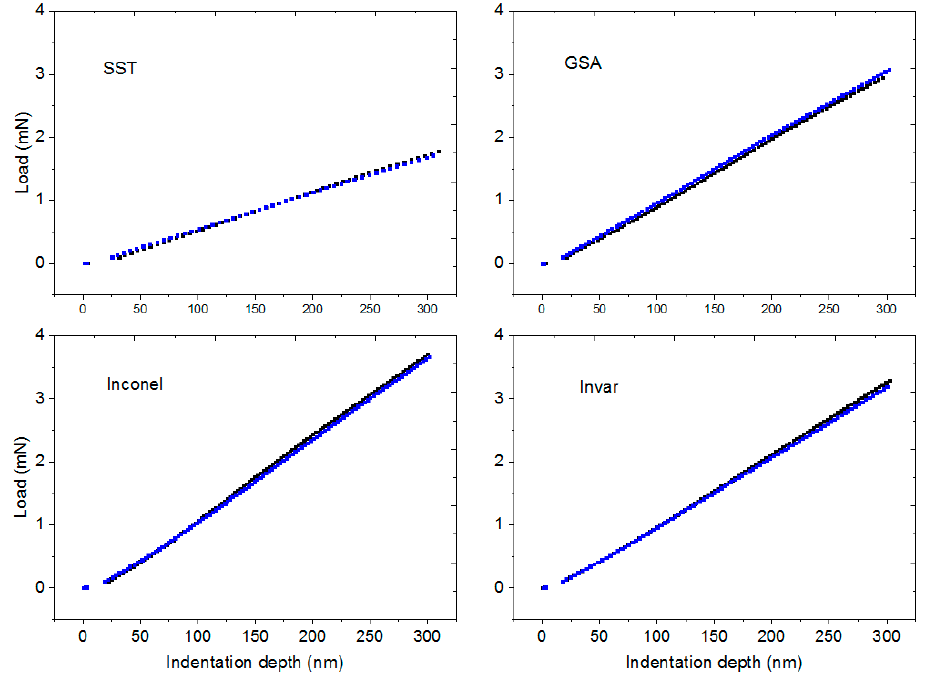
Figure 7. Examples of load–displacement curves obtained with Berkovich indenter. The data recorded in two different film points for the indentation depth not exceeding 300 nm are presented.